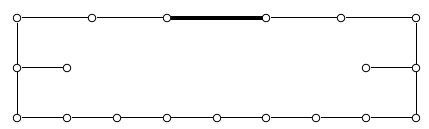
Figure 7. Tumarkin’s hyperbolic lattice Γ 16 ⊂ Isom H